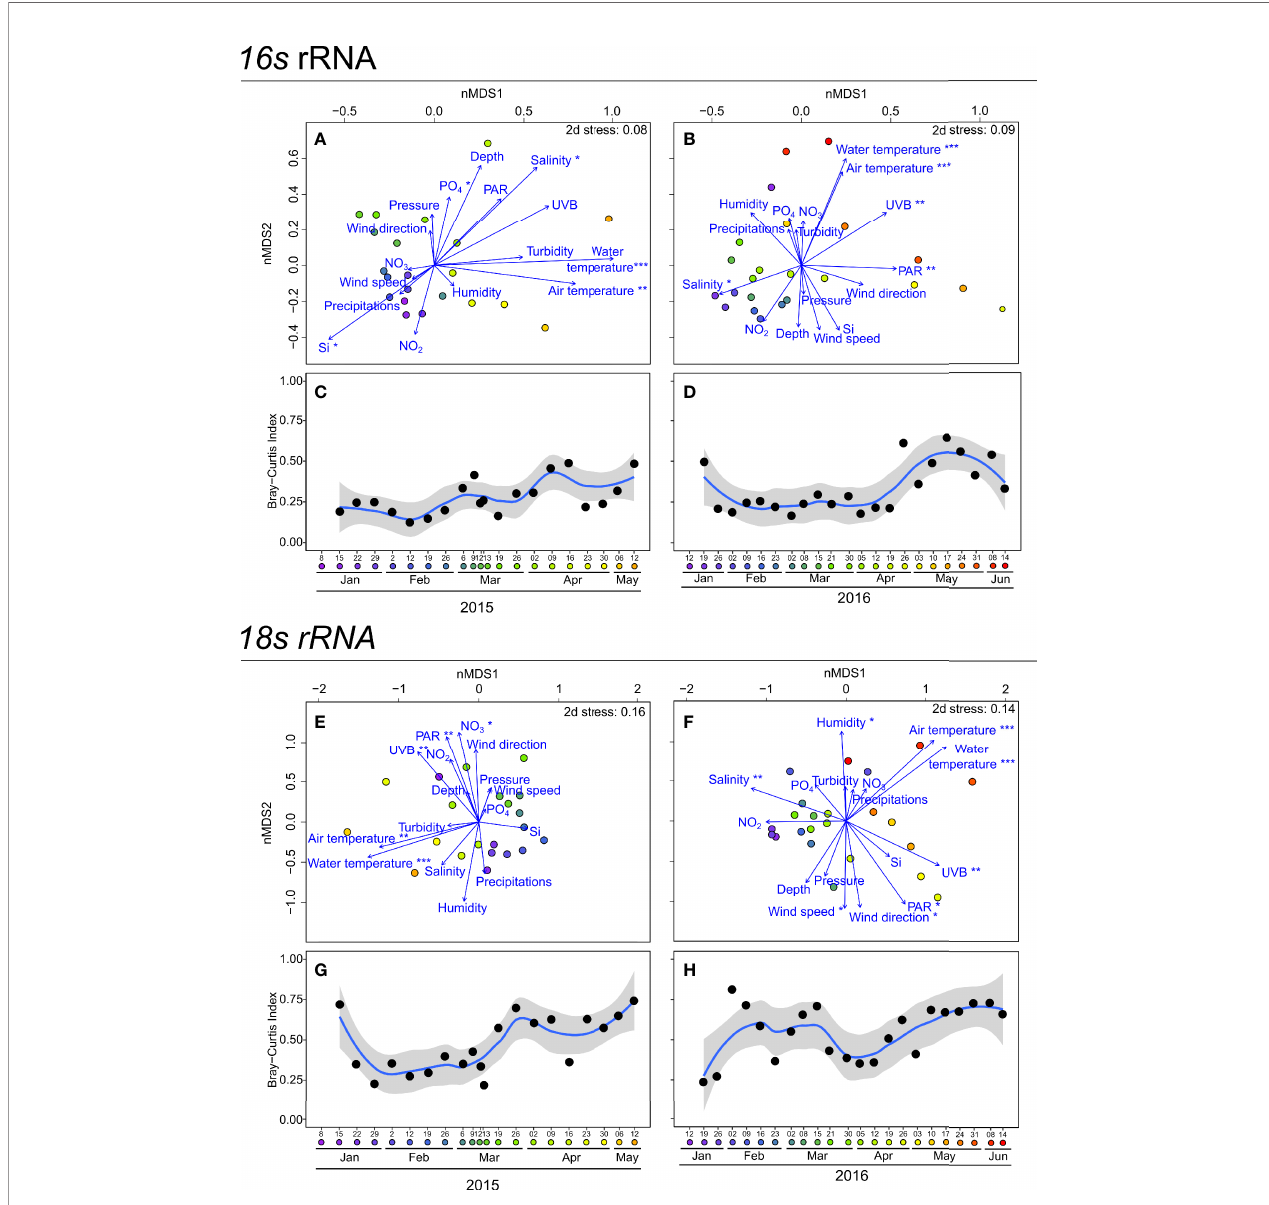
FIGURE 2 | Non-metric multidimensional scaling(nMDS; (A,B, E,F) and Bray-Curtisdissimilarity index (C, D,G,F) , of16s (A, C, E, G) and 18s rRNA gene unicellular OTUs (B, D,F, H) community, for 2015 (right) and2016 (left) years. Coloured circles represent samplingdates: purplefor January, blue for March,green for April, orange for May and red for June. Blue arrows represent the projection ofenvironmental parameters. Proximity between sampling dates indicated proximity in diversity. The more samplingdates are distant, the more different their communities are. Proximity between the environmental parametersandsamplingdates indicates the environmental factors characteristicof these samplingdates. Asterisks represent signi fi cance levelsof correlation between fi ttedenvironmentalparametersand nMDS axis, calculated using a linear model includingboth axes. * represents p- value < 0.05; **represents p- value < 0.01; and *** represents p- value < 0.001. Environmental parameters signi fi cantly correlated to axes best explainedthe community diversity. The Bray-Curtisdissimilarity index point represents the similarity value with the previousdate for each sampling date. As an example, in 2015, the 15 Januaryindex value isthe similarity index between 15 Januaryand 8 January. The temporal Bray-Curtisdissimilarity index dynamicwas smoothed usinga LOESS function, representedas a blue curve. Grey background isthe 95% con fi dence interval of the LOESS smoothing